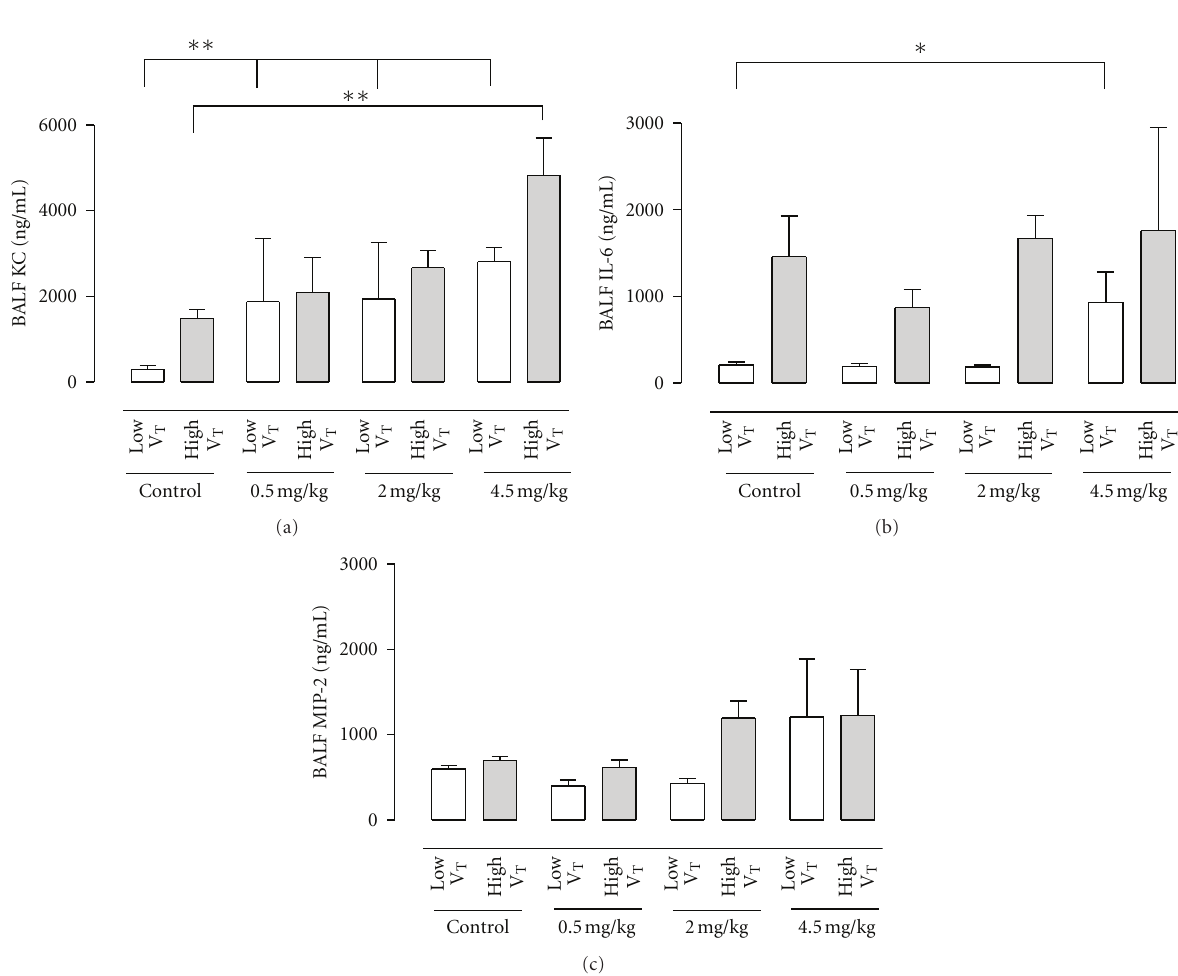
undergoing surgery or su ff ering from an inflammatory